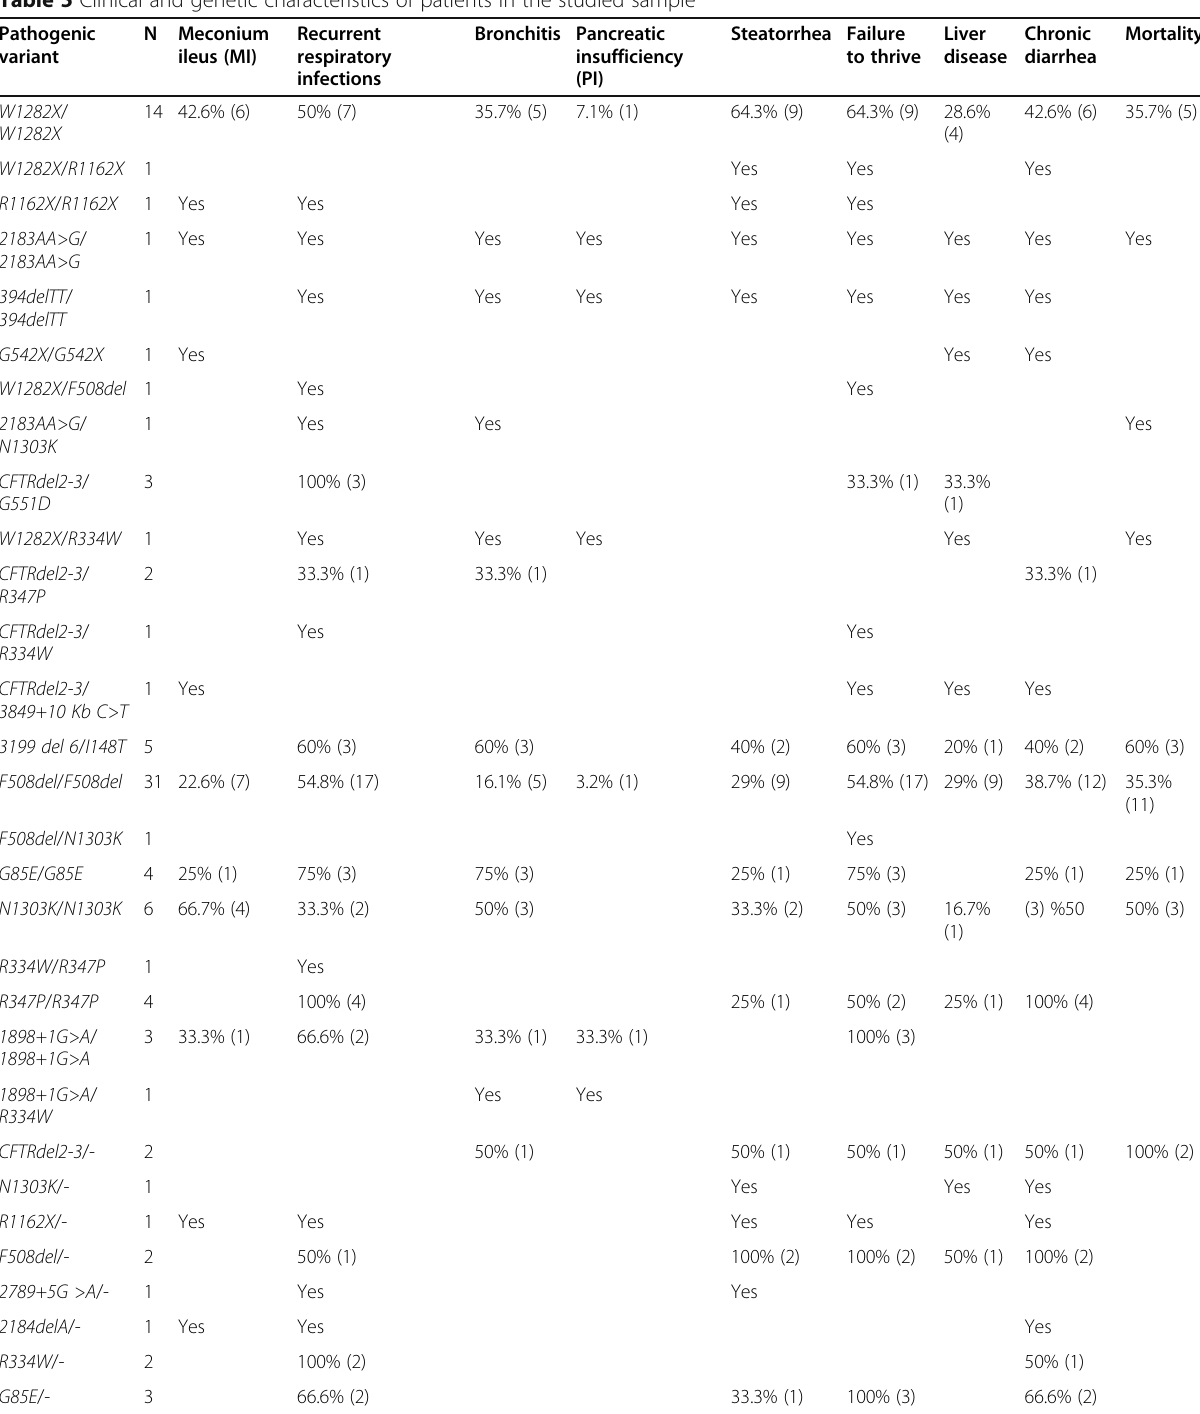
Table 5 Clinical and genetic characteristics of patients in the studied sample Pathogenic